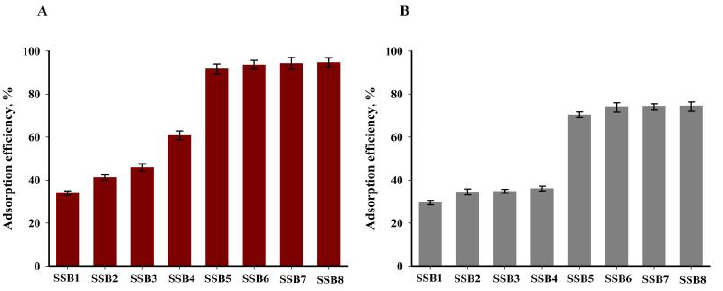
Figure 12. The results of adsorption of Cu 2+ ( A ) and Zn 2+ ( B ) on various sorbents ( T = 30 °C, t = 240 min, c = 100 mg·dm −3 , pH = 5, mass of adsorbent = 6.67 g·dm −3 ). t = 240 min, c = 100 mg · dm − 3 , pH = 5, mass of adsorbent = 6.67 g · dm − 3